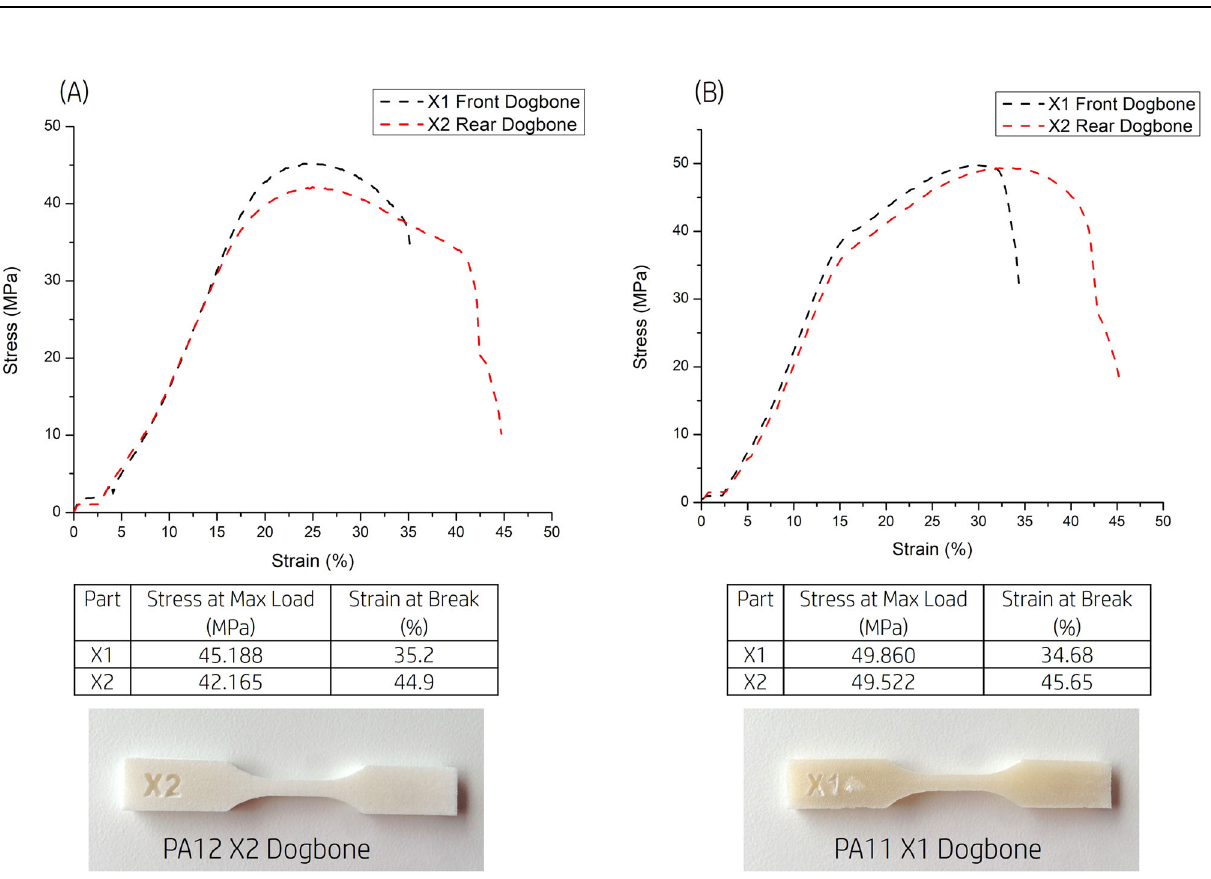
Fig. 8 | Colored and White tensile bars and stress analysis bracket printed with AFA. A Color ASTM type V dogbones. B 3D stress analysis bracket printed with AFA agent and PA-12 build material with only sandblast post processing. Colored parts printed with AFA when used with other colored inks.